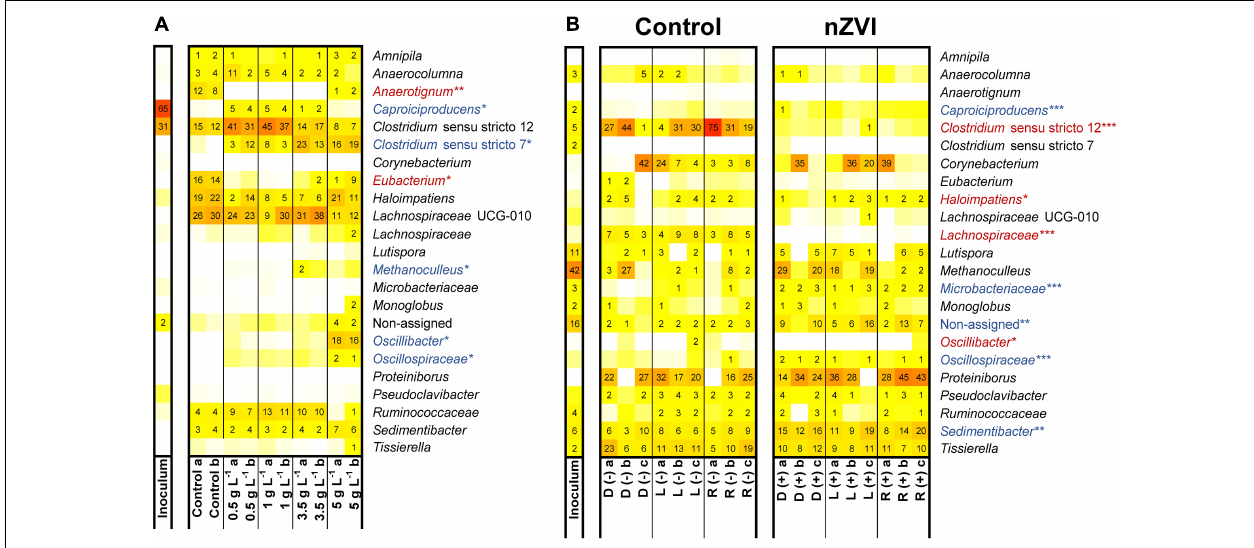
FIGURE 5 | Microbiome composition in experiment II (A) and experiment IV (B) . Experiment IV used D-lactate (D), L-lactate (L) or racemic lactate (R) in the absence (–) or presence (+) of nZVI (1 g · L − 1 ) ( B ). Blue and red shaded taxa indicate whether relative abundance was found positively or negatively correlated with nZVI presence (*** indicates p < 0.0005; ** indicates p < 0.001; * indicates p <